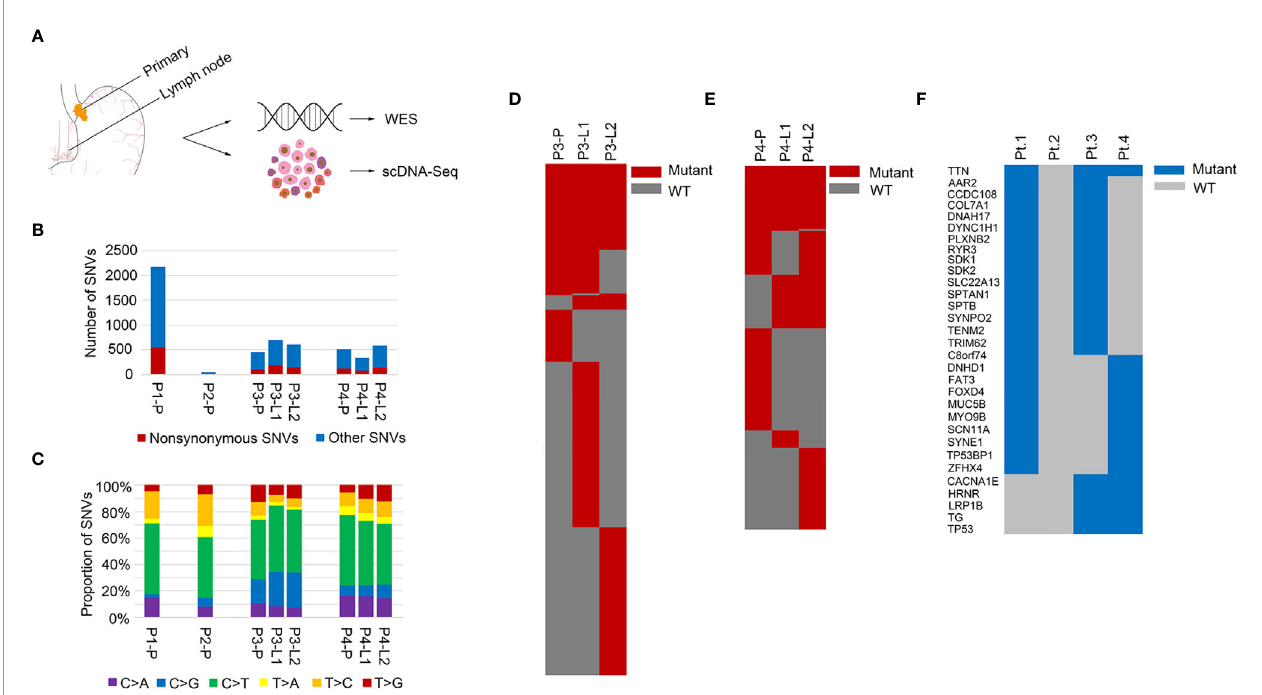
FIGURE 1 | Mutation landscapes of the GEJ cancer patients. (A) Overview of the project: genomic pro fi ling of primary tumor and lymph node metastases in the GEJ cancer patients. WES: whole exome sequencing. (B) The number of somatic mutations was shown. X axis represented different samples and Y axis represented the number of SNVs. (C) Mutation spectra of primary and lymph node sites were shown. X axis represented different samples, Y axis represented the proportion of SNVs, and different colors represented different mutation types. (D) A heatmap showed the distribution of nonsynonymous SNVs of primary and lymph nodes in Pt.3. (E) A heatmap showed the distribution of nonsynonymous SNVs of primary and lymph nodes in Pt.4. (F) A heatmap showed the recurrent mutated genes shared in at least two of the four GEJ cancer